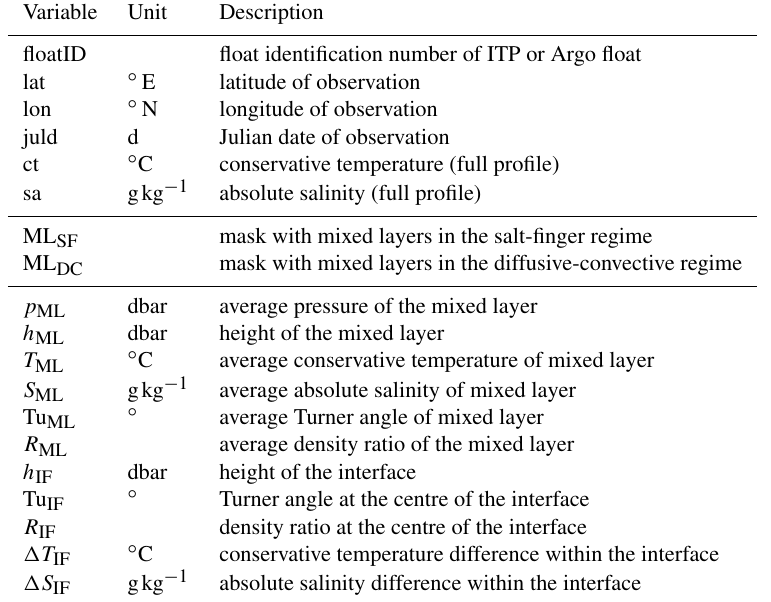
Table A1. Metadata of all variables that are saved in the